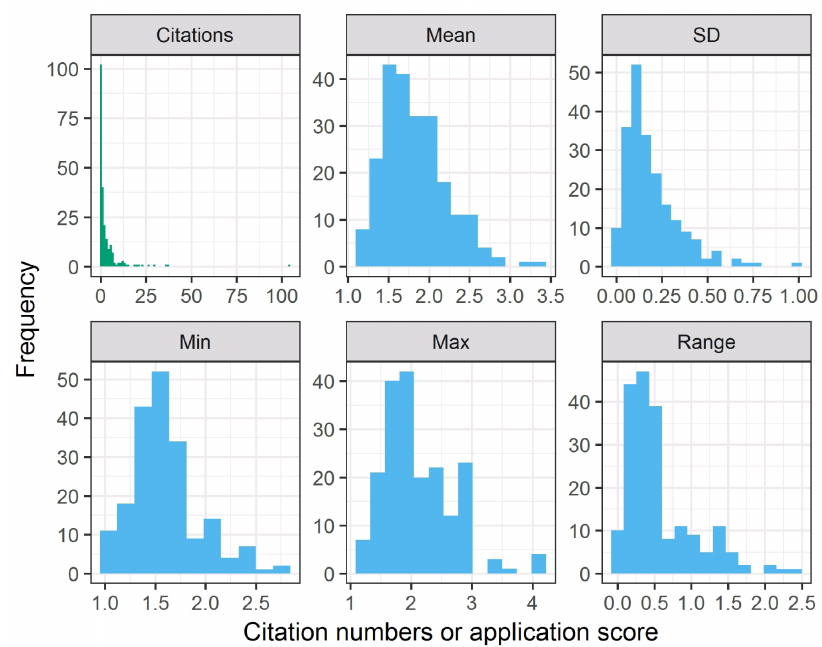
Figure 1. Histograms of total relative citations (green) and application score statistics (blue). The lower the mean score, the better the application did in peer